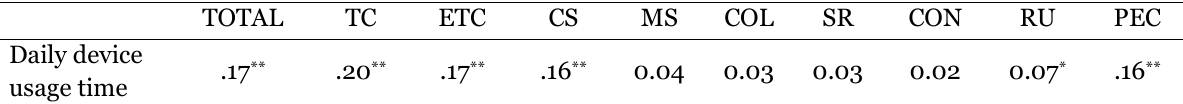
Correlation Between Scores and Daily Device Usage